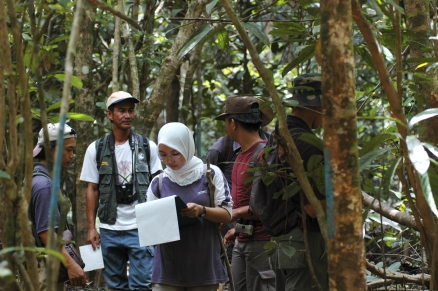
KOCP conducts orang-utan ecological fieldwork during a joint program with staff from Sabah parks in the Lower Kinabatangan Wildlife Sanctuary.(Image: Jamil Sinyor)